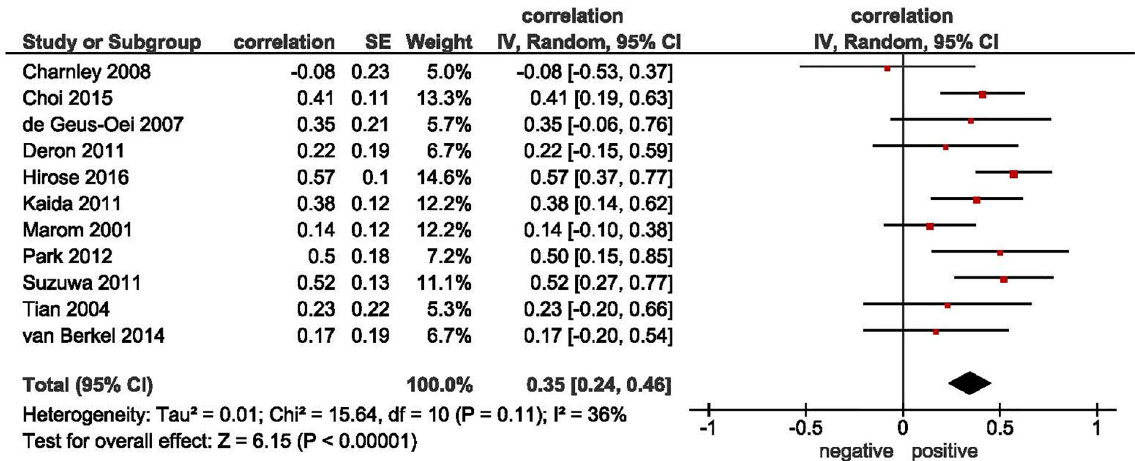
Fig 5. Correlation between SUVmax and GLUT 3 expression. Forrest plots of the correlations coefficients between SUVmax and GLUT 3 in 11 studies comprising 405 patients. The pooled correlation coefficient was r = 0.35 (95%CI 0.24–0.46).